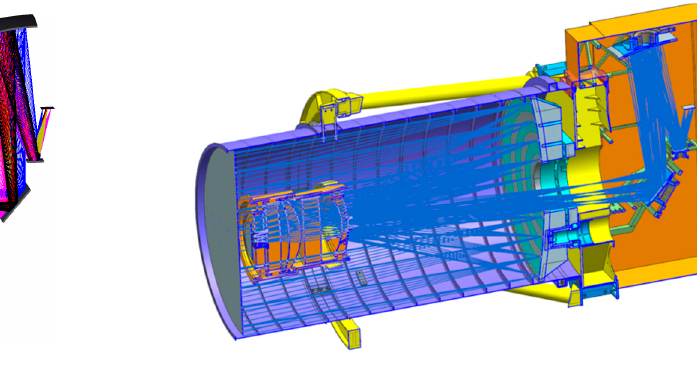
Figure 9. ( a ) The optical system three-dimensional layout of the common-aperture camera. ( b ) the opto-mechanical layout of the common-aperture camera.